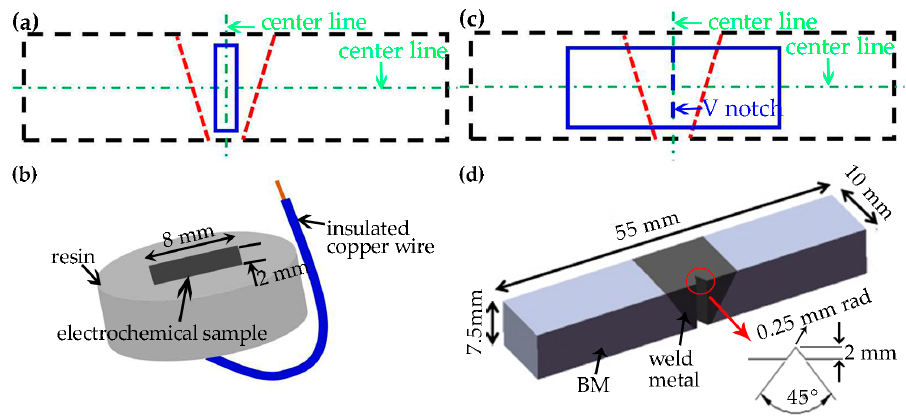
Figure 3. Schematic diagrams of the electrochemical test sample and the impact toughness sample: ( a , b ) sampling location and package illustration of the electrochemical test specimen; ( c , d ) sampling location and stereo view of the impact toughness specimen. (The rectangles with blue solid lines represent the tested samples in ( a , c )).